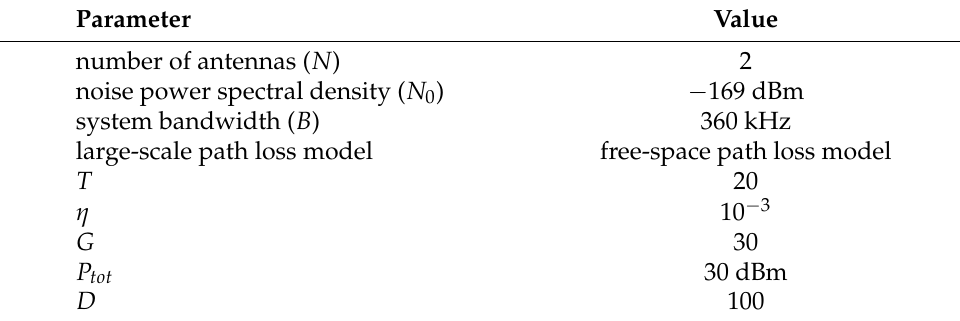
Table 1. Simulation